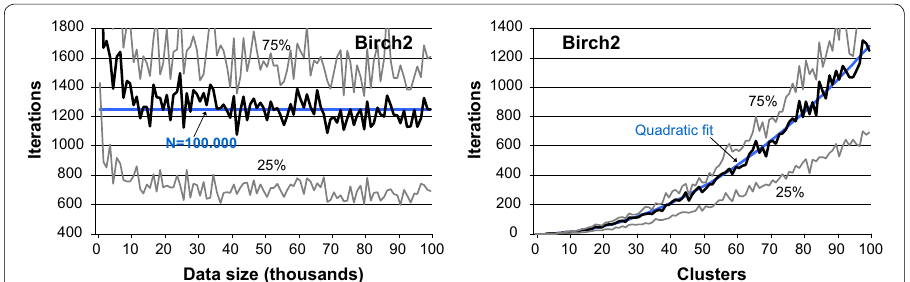
Fig. 15 Number of iterations needed to find the correct clustering for subsets of BIRCH 2 when varying the size of data (left), and number of clusters (right). The black line is the average of 100 runs, and the 25 and 75% quartiles show the level of variation between the individual runs. The blue lines are linear (left) and quadratic (right) fits to the